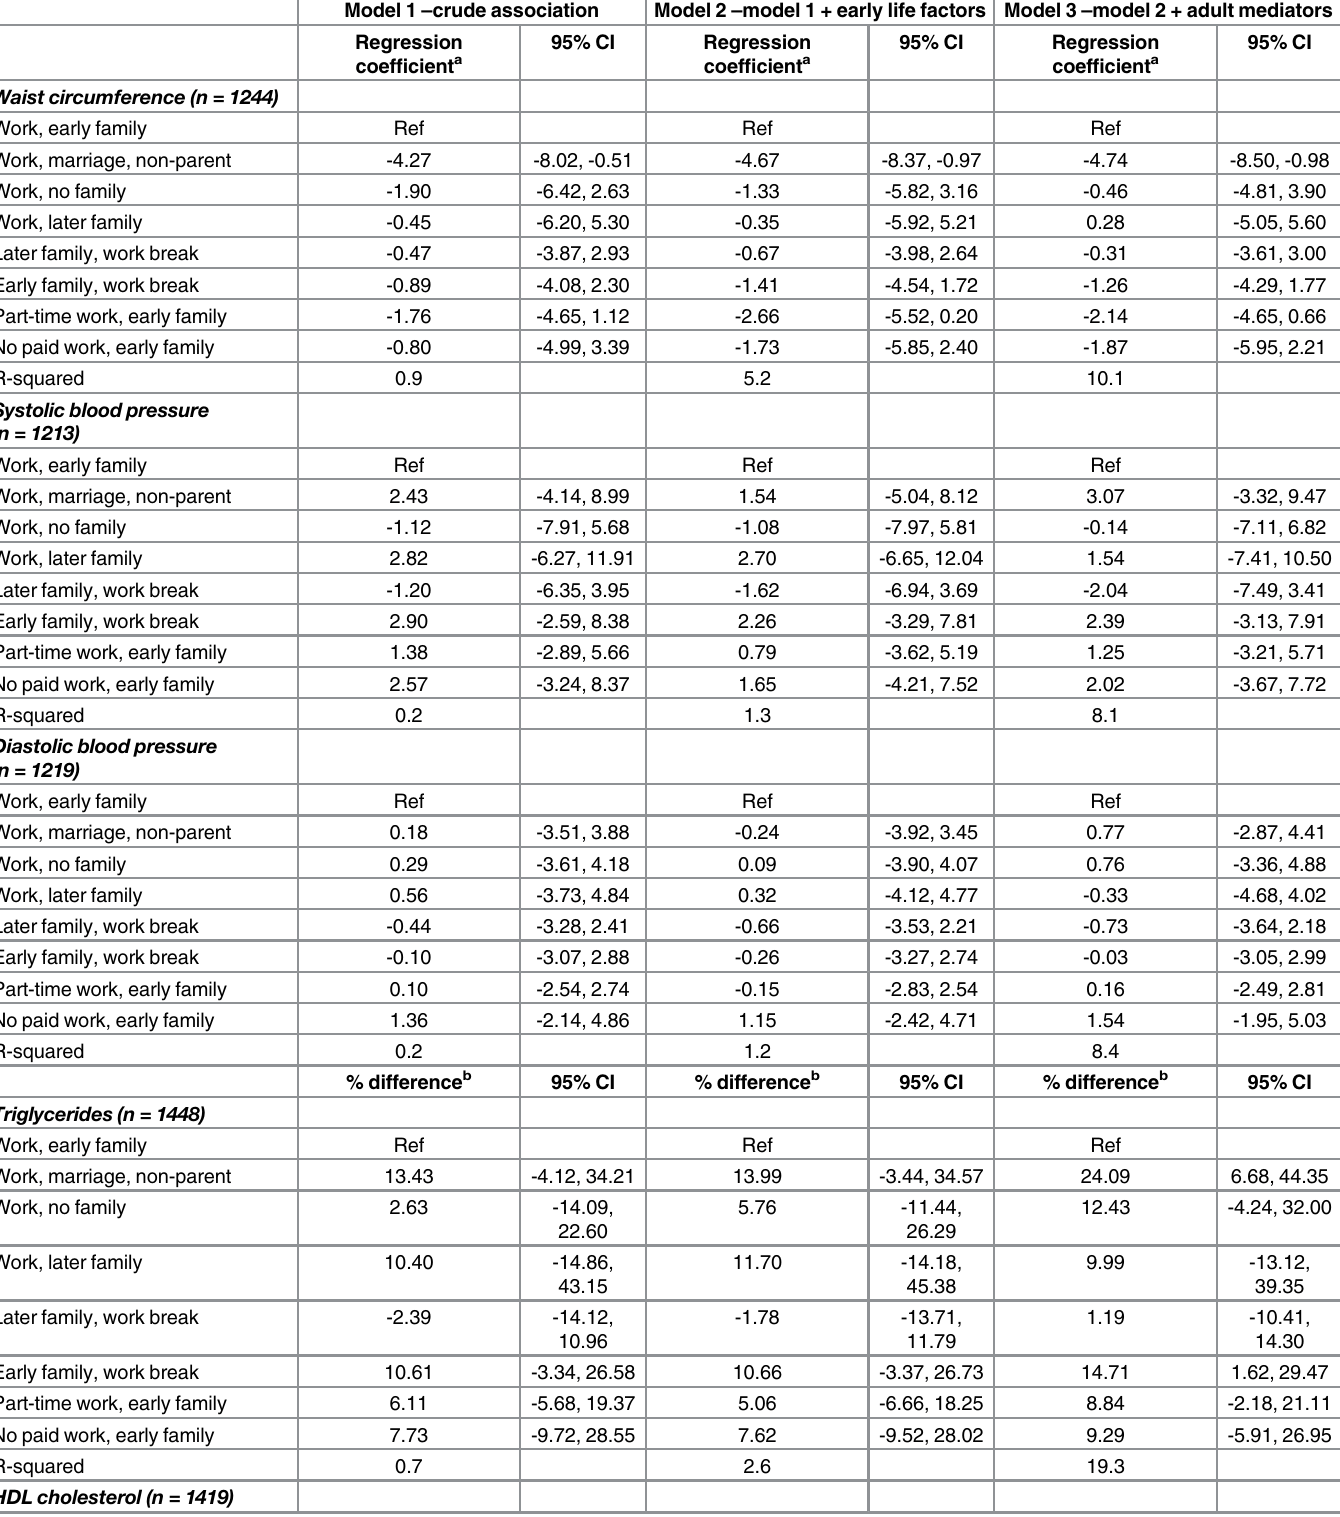
Table 3. Associations Between Work-Family Life Courses and Metabolic Markers at Age 53 for